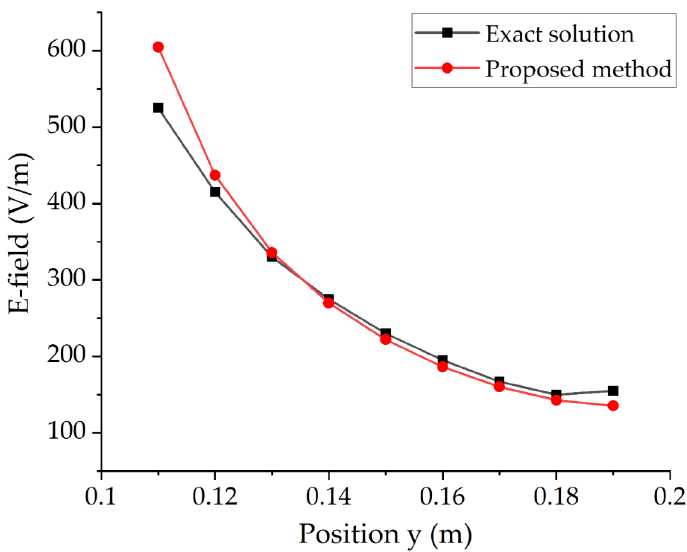
Figure 4. Comparison results of induced electric field by Hertzian electric dipole. As shown in Figure 4, the result of the proposed method is consistent with the the- oretical result.